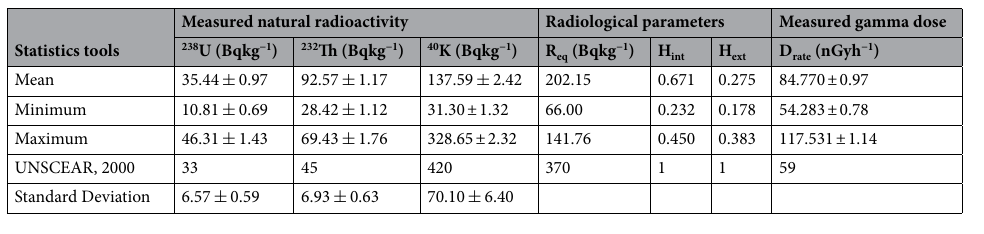
Table 3. Summary of statistic tools used in this study.